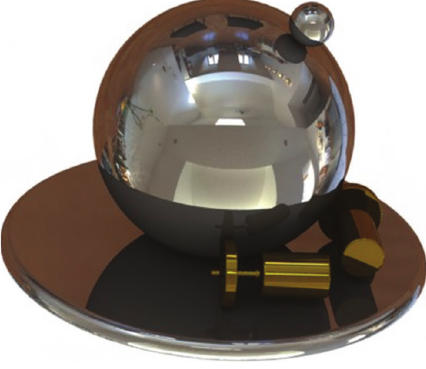
Figure 1: A ball on a sphere system.